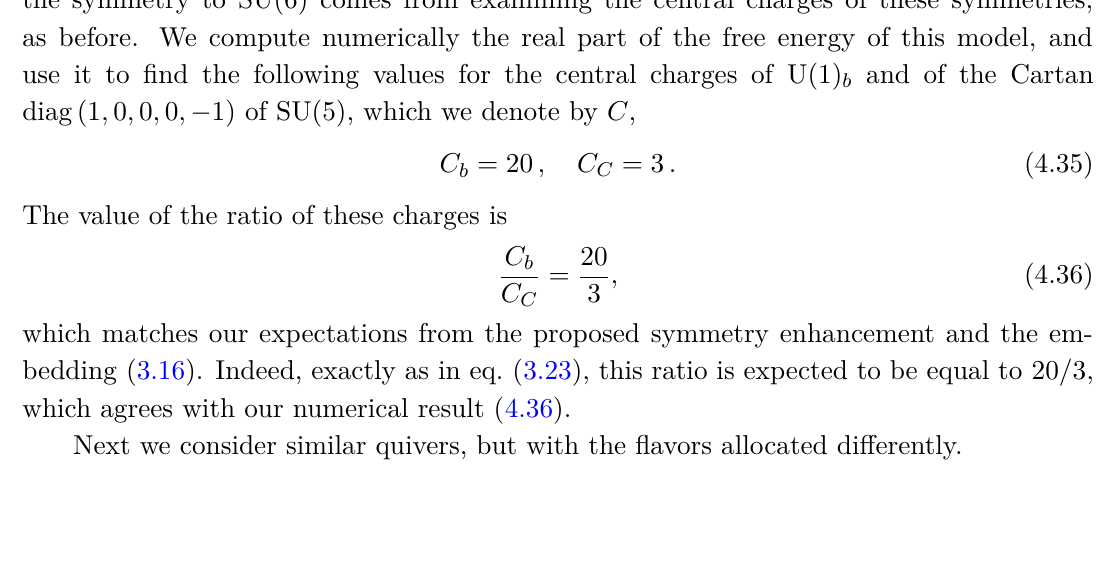
Figure 8 . The 3 d quiver theory associated with the compactification of the 5 d E 6 SCFT on a torus √ with flux ( 3; 1 , 1 , 1 , 1 , 1) . There are Chern-Simons terms of levels ( 1 contains eight cubic superpotential interactions, four of which running along the triangles, and the other four being the flipping superpotentials. Additionally, there are four monopole superpotential of the type (1 , 1) for all adjacent SU(2) groups, properly dressed by SU(2) × SU(2) bifundamentals to form a gauge